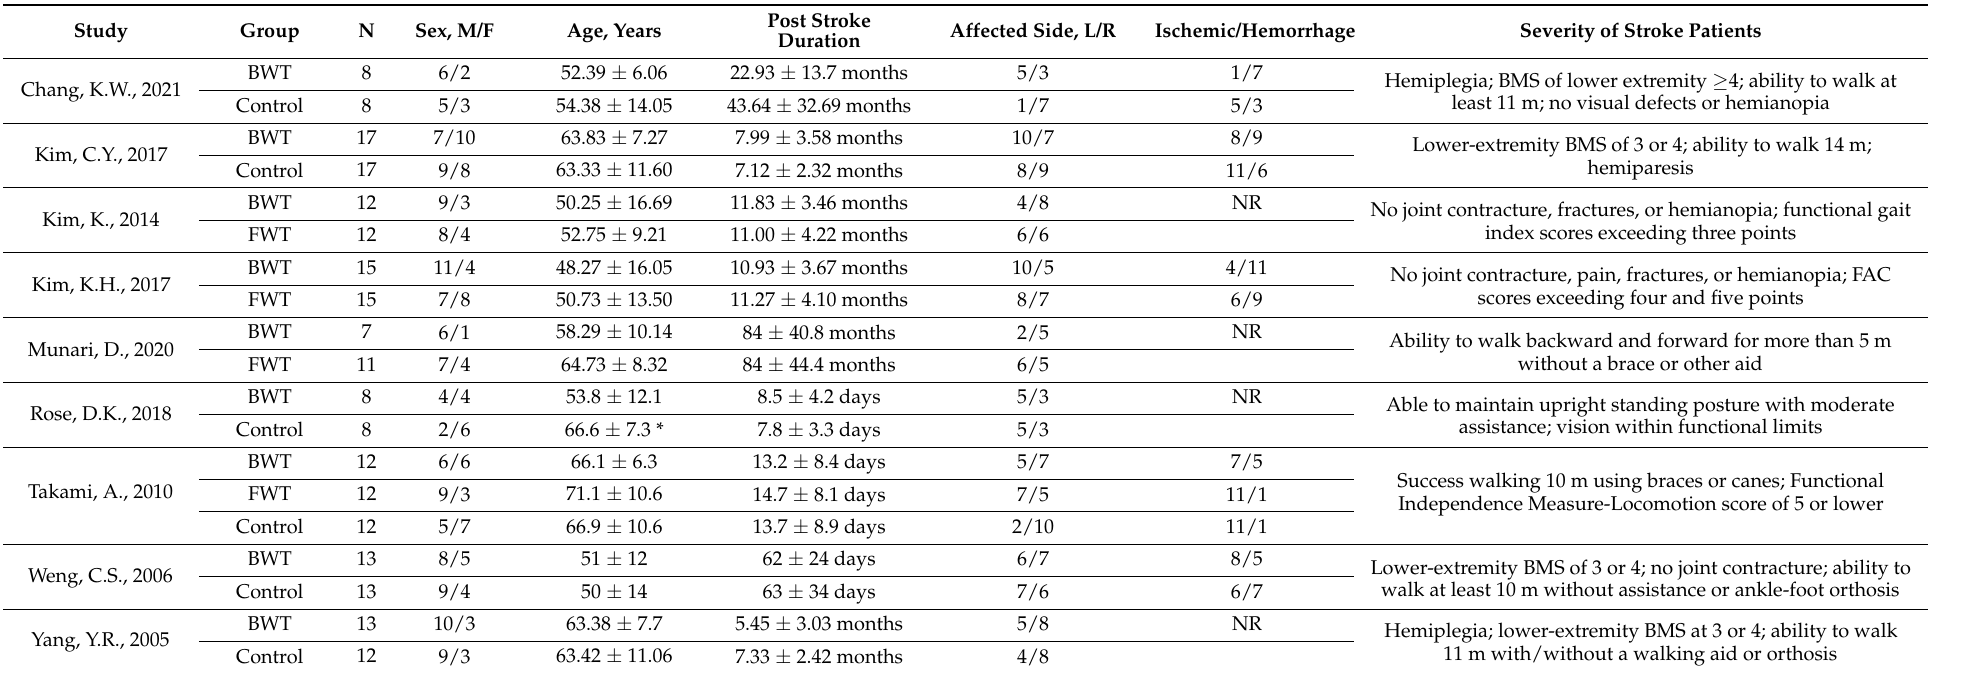
Table 2. Characteristics of nine included studies in this